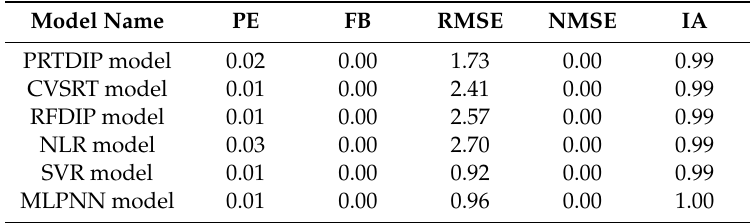
Table 4. Modeling accuracy of the prediction